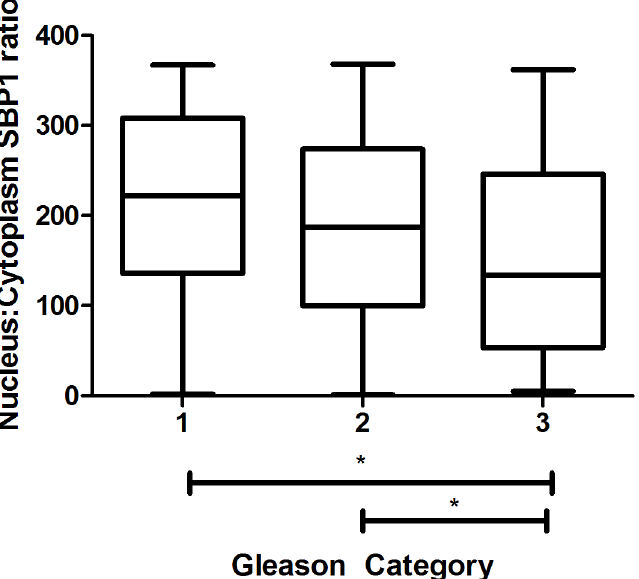
Fig 3. Lower nucleus:cytoplasm SBP1 ratio is significantly associated with advanced prostate cancer. Patients in the prostate cancer outcome microarray were distributed into three categories (Gleason Category) based on Gleason score (A). Mean quantified tissue SBP1 was ranked for all patients and assigned a score from 1 – 368 based on relative SBP1 levels where the patient with the lowest tissue nuclear: cytoplasmic ratio of SBP1 received a score of 1, and the patient with the highest ratio received a score of 368. Box-and-whisker plots indicate the range of scores from patients in each category (vertical lines) and the range of the first and third quartile in each category (boxes). The horizontal line inside the box indicates the median.